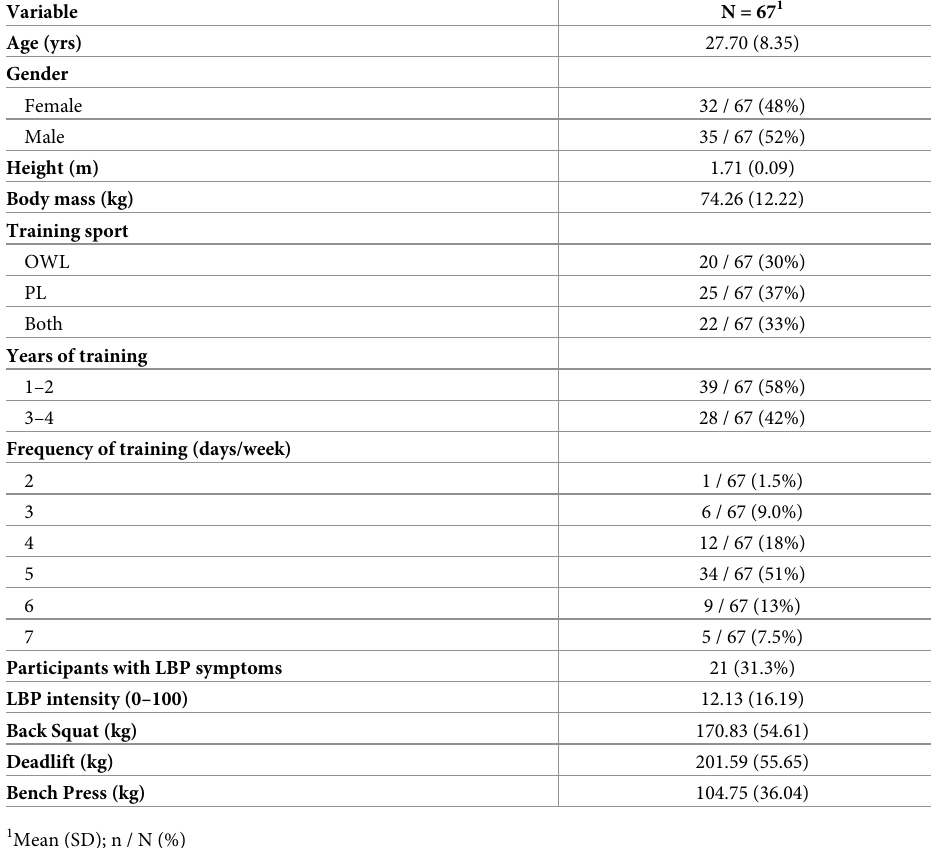
Table 2. Descriptive characteristics of